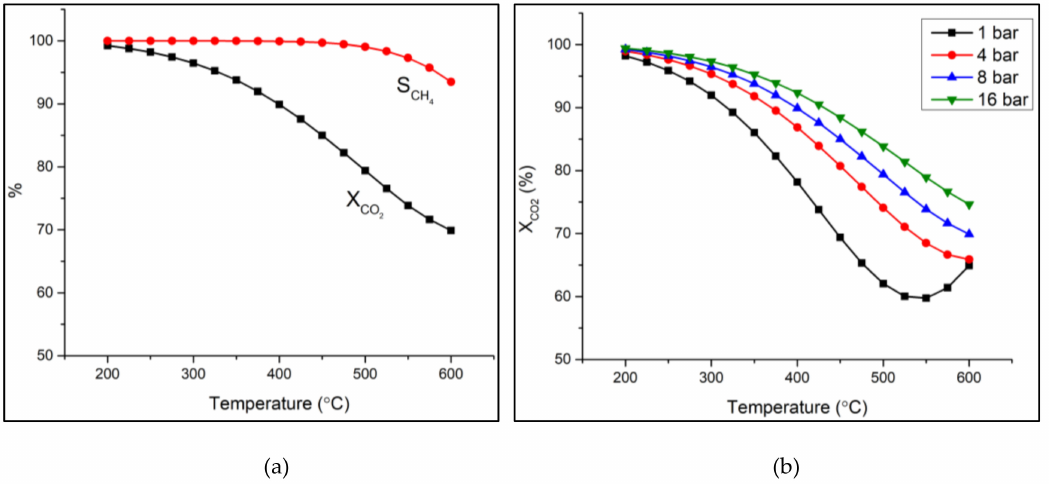
Figure 3. Thermodynamic equilibrium curve of ( a ) CO 2 conversion(X CO2 ) and methane selectivity (S CH4 ) at 8 bar, 200–600 ◦ C, ( b ) CO 2 conversion (X CO2 ) at 1, 4, 8, and 16 bar pressure at 200–600 ◦ C using CO 2 :H 2 , 1:4